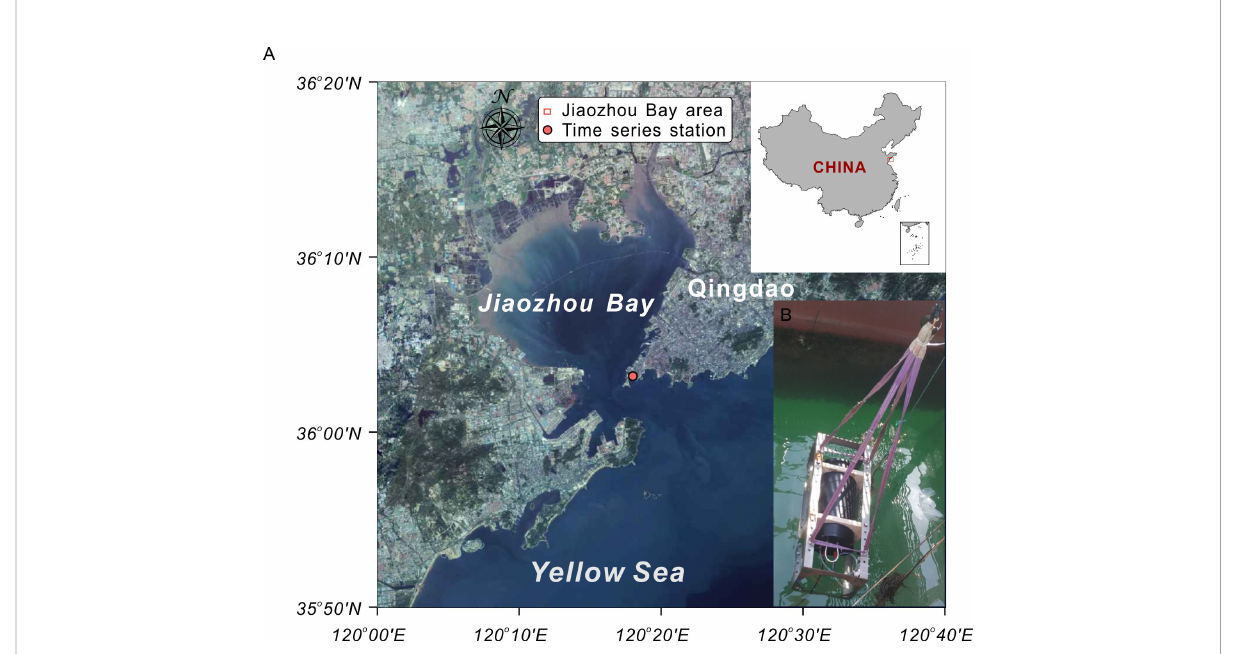
FIGURE 2 (A) Map of the study site in Jiaozhou Bay, China. The area of the Jiaozhou Bay was downloaded from https://www.ovital.com/. (B) Long-time series radon measurement was conducted from a fi xed platform using the submersible OUC-Rn